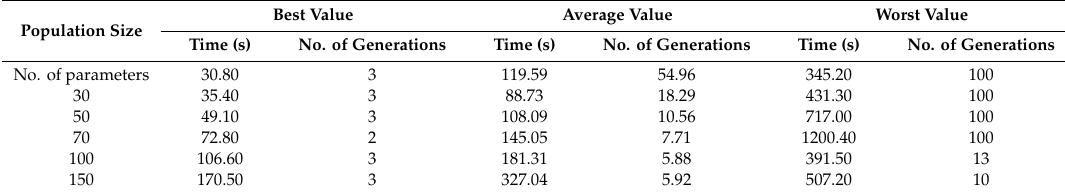
Table 3. E ff ect of population size for test case generation using the MSGA.